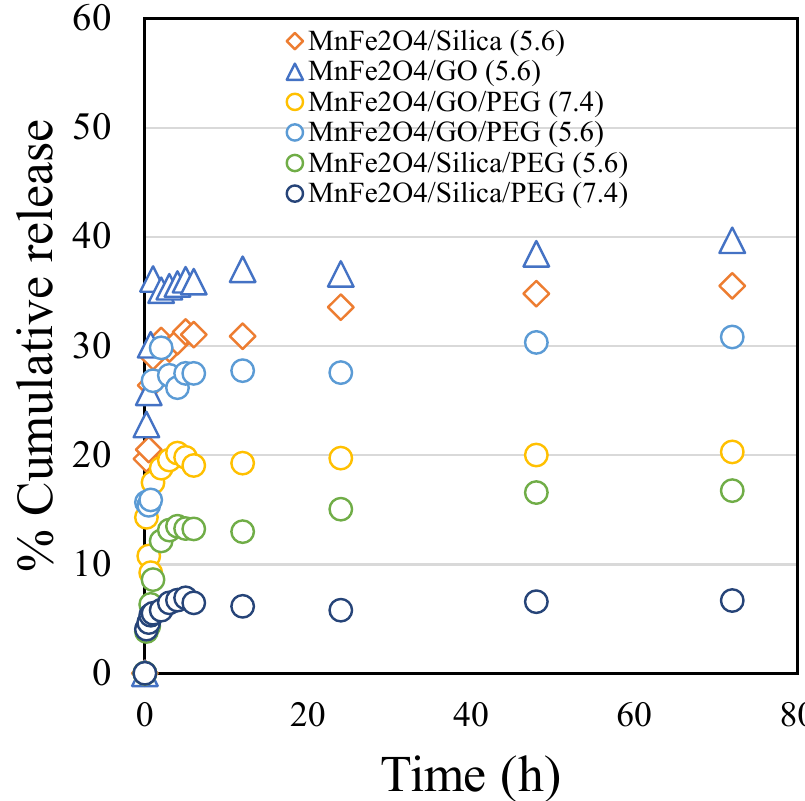
Figure 3. The percentage cumulative cisplatin release in pH 5.6 and 7.4 conditions for 72 h from: MnFe 2 O 4 /silica pH 5.6 (orange diamond); MnFe 2 O 4 /GO pH 5.6 (blue triangle); MnFe 2 O 4 /GO/PEG pH 7.4 (yellow circle); MnFe 2 O 4 /GO/PEG pH 5.6 (blue circle); MnFe 2 O 4 /silica/PEG pH 5.6 (green circle); and MnFe 2 O 4 /silica/PEG pH 7.4 (dark blue